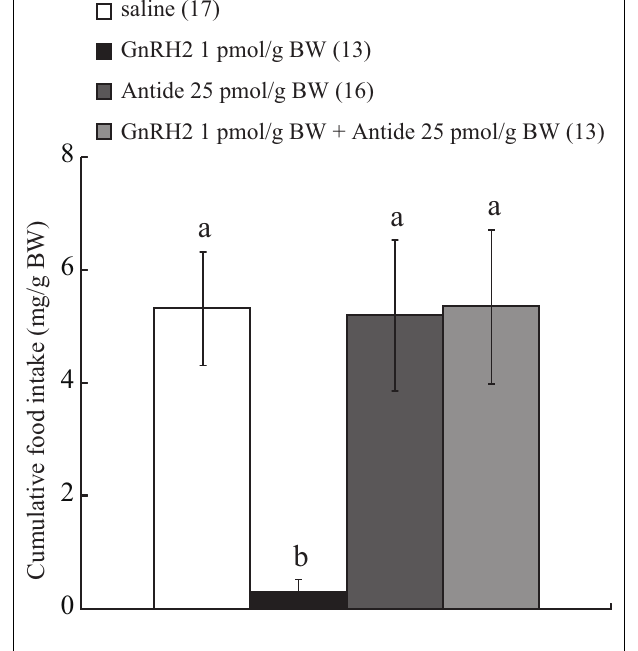
FIGURE 2 | Effect of ICV administration ofAntide on the anorexigenic action of GnRH2. The results are expressed as a percentage of the control, i.e., vehicle-injected, fish. Each column and bar represents the mean and SEM, respectively, and the numbers in parentheses in the panels indicate the number of fish in each group. Significance of differences among experimental groups was evaluated by two-way ANOVA with